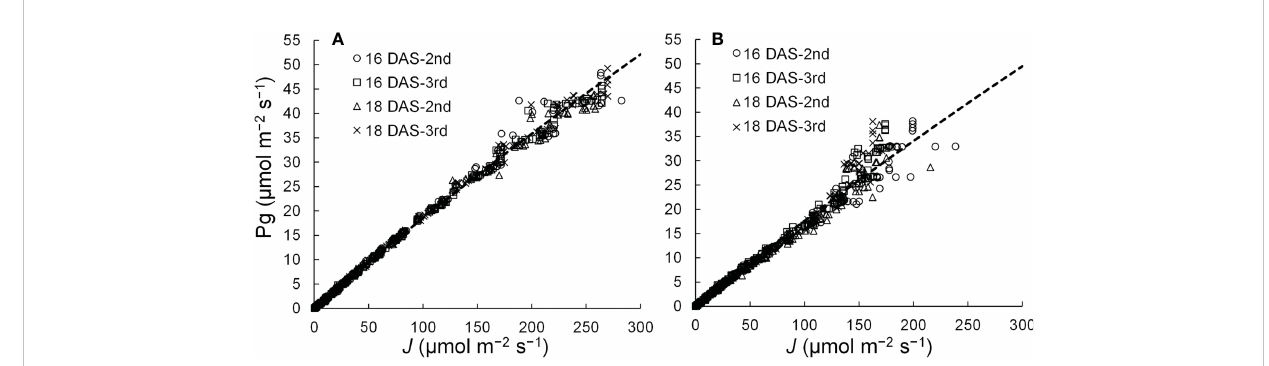
FIGURE 4 Relationships between the electron transport rates ( J ) and gross photosynthetic rates (Pg) of adaxial (A) and abaxial (B) surfaces of the 2nd and 3rd leaf of komatsuna 16 DAS and 18 DAS ( n = 663 –